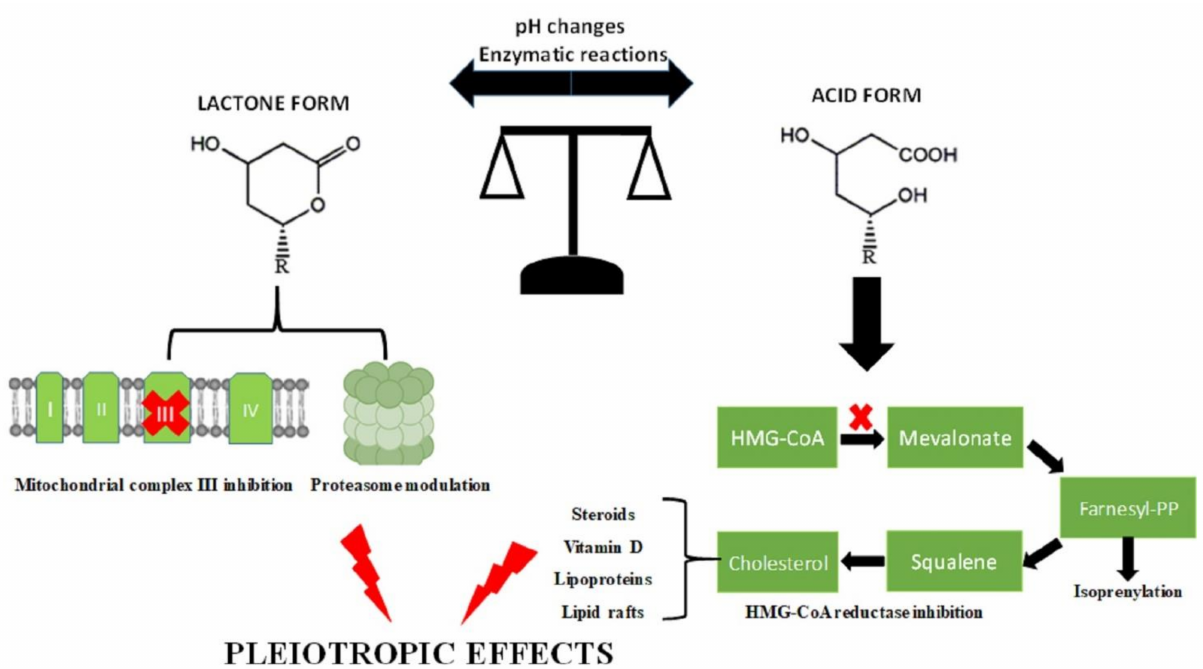
Figure 1. Schematic diagram for the possible mechanisms behind the pleiotropic effects of the lactone and acid forms of statins. The interconversion between the two forms is regulated by pH changes and enzymatic reactions. The lactone form inhibits mitochondrial complex III and modulates proteasome activities, while the acid form, inhibiting HMG-CoA reductase, reduces cholesterol synthesis and affects protein prenylation. Cholesterol reduction influences several other pathways, including steroids and vitamin D synthesis. Therefore, both lactone and acid forms can contribute to the pleiotropic effects of statins by different